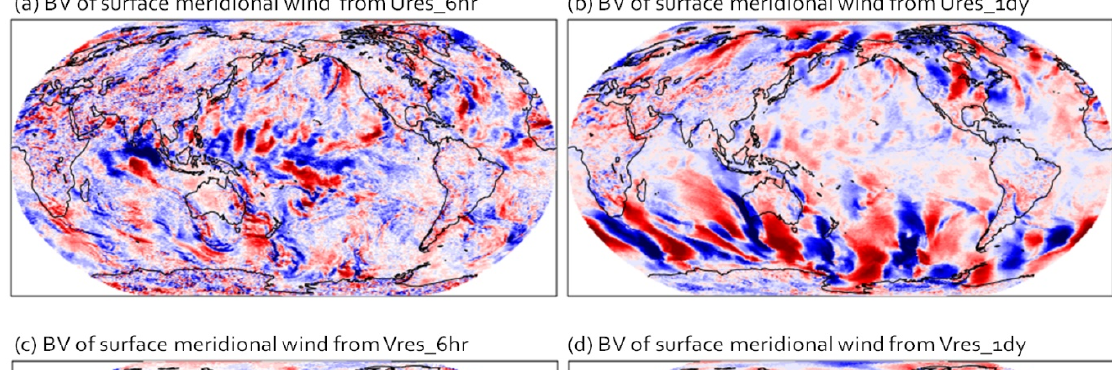
Figure 7. Same as Figure 6 except for the variable of surface zonal wind (m/s).